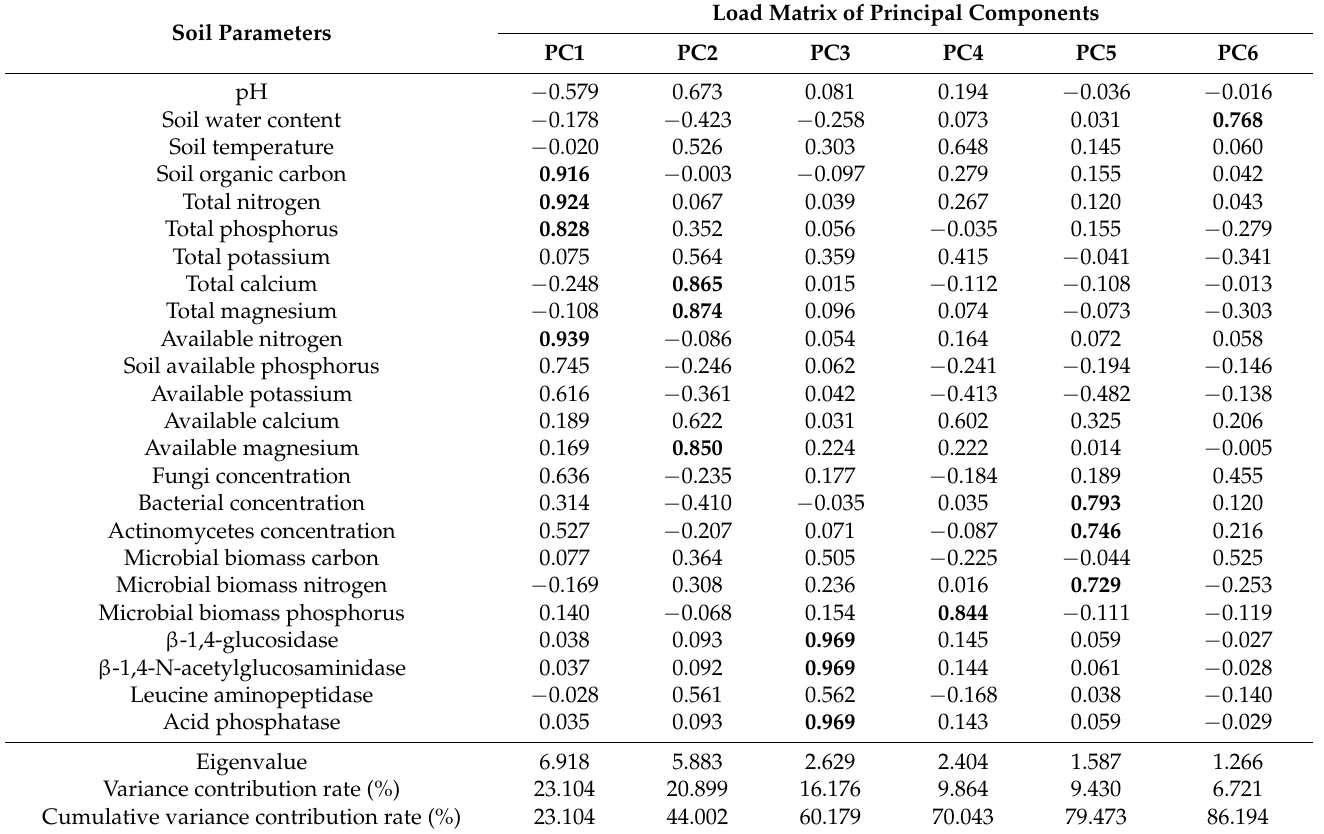
Table 4. Load matrix of principal component analysis of soil quality of Z. planispinum plantations with different planting